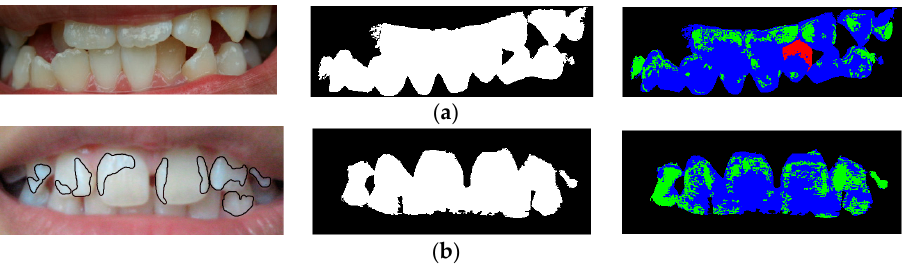
Figure 3. Examples of misclassification on the blind test set and their segmented images. ( a ) Expert’s opinion: Normal; Prediction: Stage 3 with r opaque = 19.84% and r brown = 3.23%. ( b ) Expert’s opinion: Stage 1; Prediction: Stage 2 with r opaque = 33.95% and r brown =